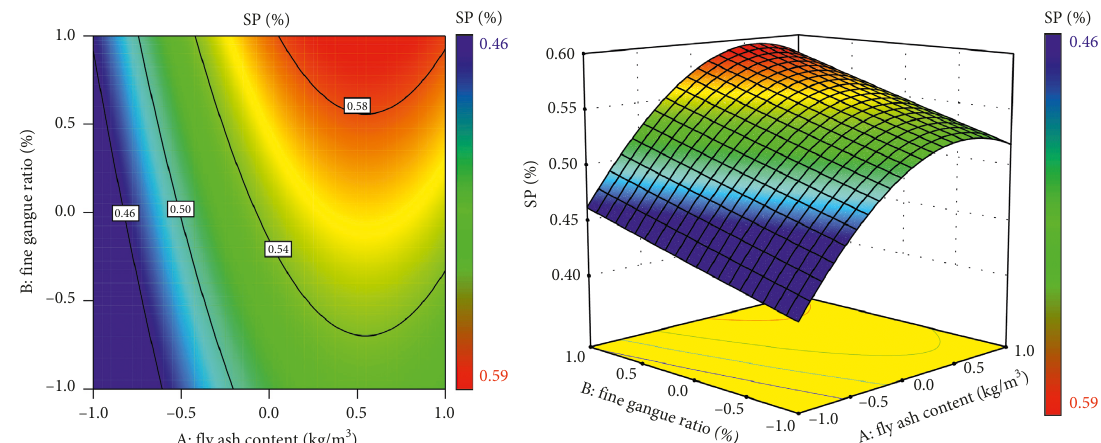
Figure 2: Influence of A, B, and their interaction on SP.